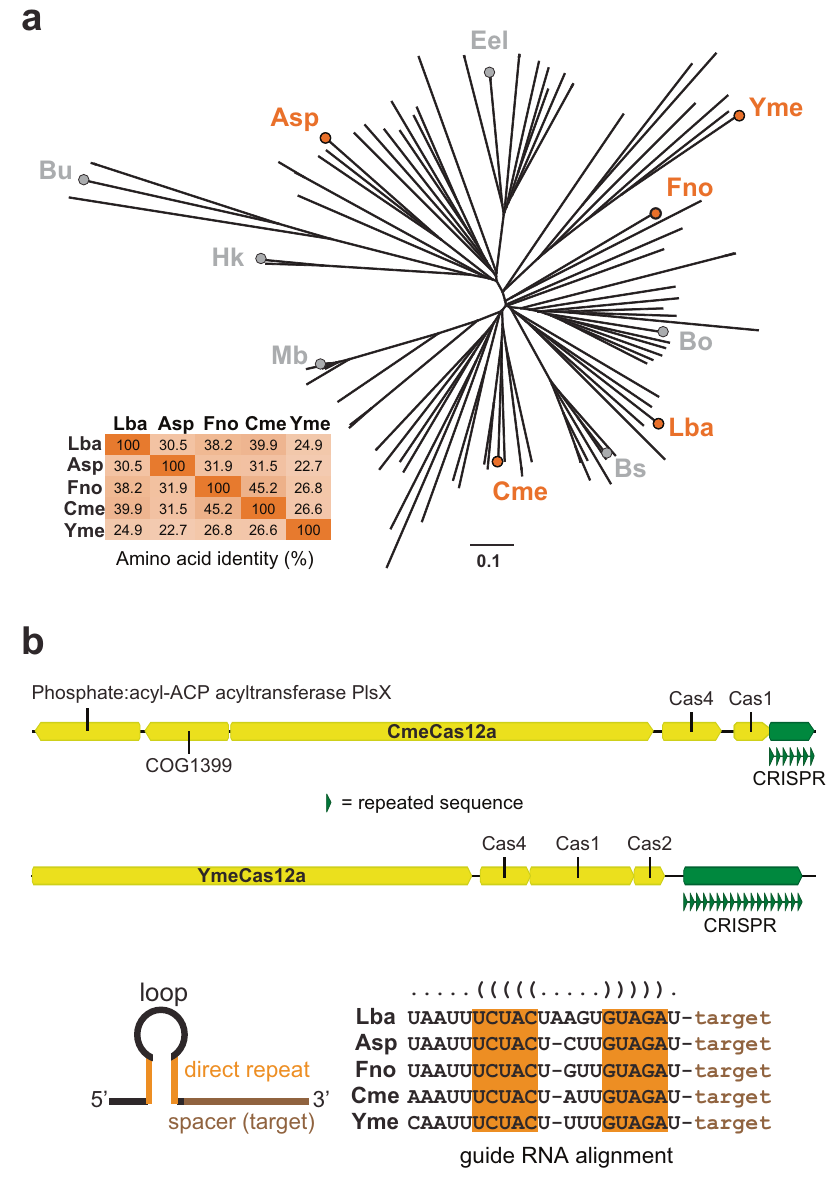
Fig. 1 Relatedness of Cas12a orthologs. a Phylogenetic tree of 100 Cas12a protein sequences. The branches of the tree corresponding to the fi ve proteins examined in this study are marked with an orange circle and the table shows their percentage of shared amino-acid sequence. b Cartoon representation of the Cme and Yme loci from metagenomic data and an alignment of Cas12a crRNA sequences. DNA CRISPR repeat sequences shown in green are representative of the crRNA sequence utilized by the corresponding Cas12a protein. A typical crRNA is also represented as a cartoon and has 20 nt of target sequence appended to the 3 ′ -end of the sequence shown in the alignment next to (Supplementary Figure S3). Libraries of circular dsDNA sub- strates were exposed to Cas12a RNPs loaded with crRNA cor- responding to the target and incubated for 2 min at 37 °C for Lba, Asp, and Fno and 55 °C for Cme and Yme. Linearized DNA was end-repaired, ligated to adapters, and subjected to Illumina sequencing. The remaining circular DNA could not be sequenced since it lacked free ends for adapter ligation. Figure 3 shows, in graphical form, position weight values calculated by using the frequency of nucleotides at each of the 10 randomized PAM positions in the Cas12a RNP exposed samples normalized to a BstXI restriction enzyme digested sample as described in the methods. The BstXI digested sample serves as a control to determine the nucleotide frequency in the PAM positions prior to Cas12a exposure.